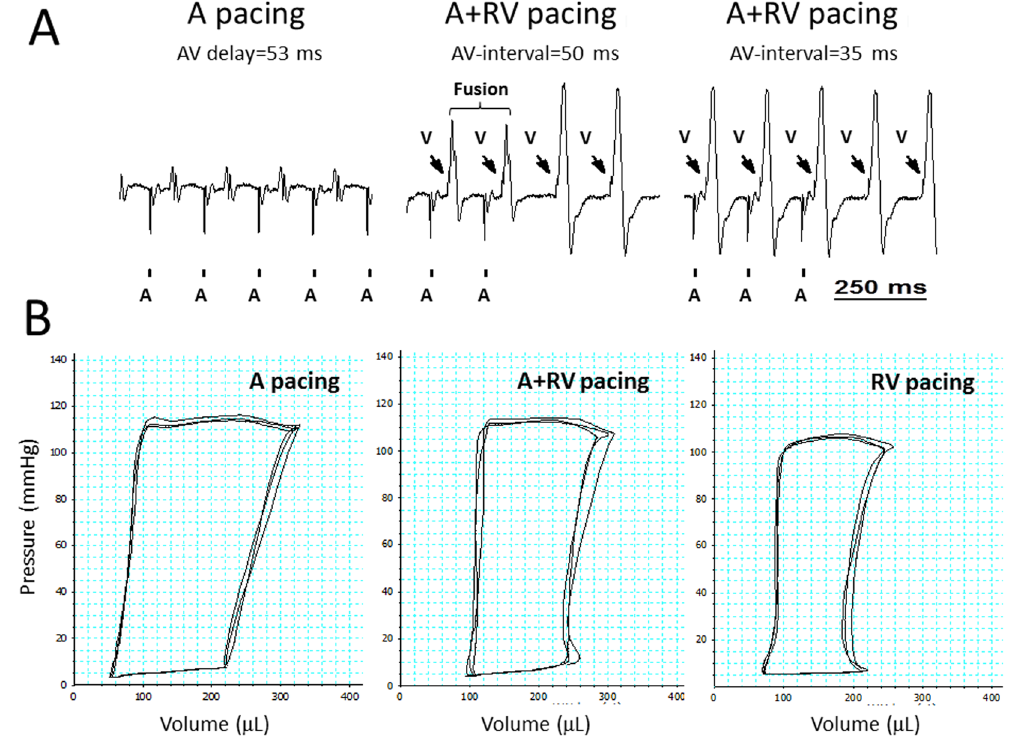
Figure 1. RV pacing-induced decrease in LV hemodynamic performance is related to both dyssynchrony and impaired AV coupling. Analysis of rats implanted with an atrial ( A ) bipolar electrode and a right ventricular (RV) bipolar electrode for sequential A + RV pacing. ( A ) ECG recording (lead I) during: Left ; override A pacing. Mid ; override A + RV pacing (AV-interval = 50 ms) or RV-only pacing. Right ; override A + RV pacing (AV-interval = 35 ms) or RV-only pacing. Vertical bars at the bottom indicate A pacing; arrows indicate RV pacing. Note fusion beats with an AV interval of 50 ms and absence of fusion beats when the AV interval was reduced to 35 ms. ( B ) PV-loop recordings during A pacing, A + RV pacing (using the maximal AV-interval that did not induce fusion beats) and RV-only pacing. Comparison of A vs. A + RV pacing shows the effects of LV dyssynchrony, while RV-only pacing also induces preload reduction due to impaired AV